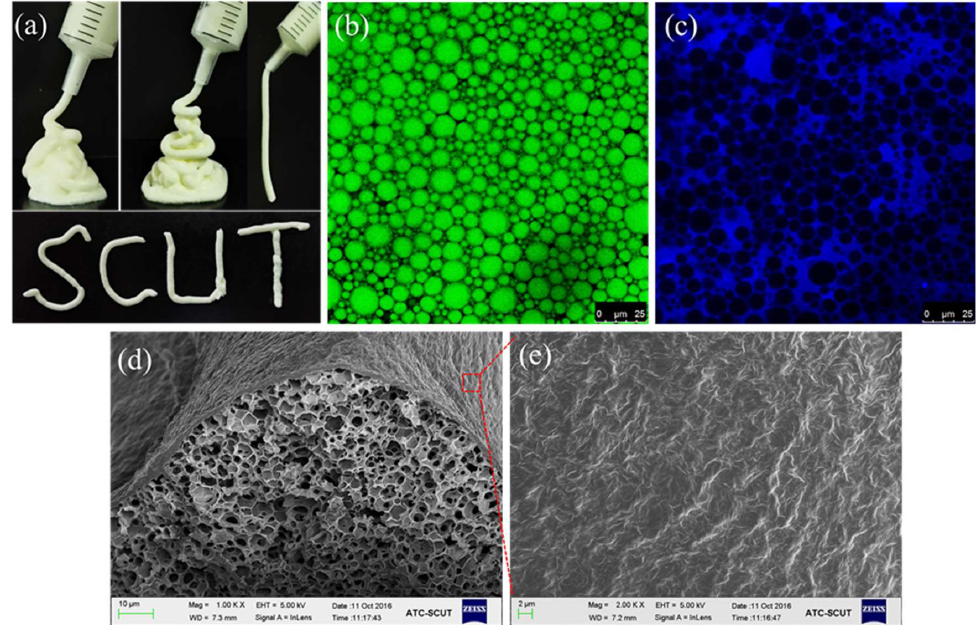
Figure 4. ( a ) Photographs of the gel emulsions (60 wt% olive oil, 2–4 wt% GA nanofibrils) with the shape of alphabets using a plastic syringe after cooling the extruded warm emulsions at room temperature (25 °C) for 1 min. ( b , c ) CLSM images of gel emulsions with 60 wt% olive oil prepared using 4 wt% GA nanofibrils. The sample was prepared with the oil dyed with Nile Red ( b ) and the GA fibrillar network dyed with ThT ( c ), respectively. ( d , e ) SEM images of 4 wt% GA nanofibril gel emulsion with 40 wt% hexane as oil phase. The sample was prepared at air-drying condition. Images were reproduced with permission from [33,34].